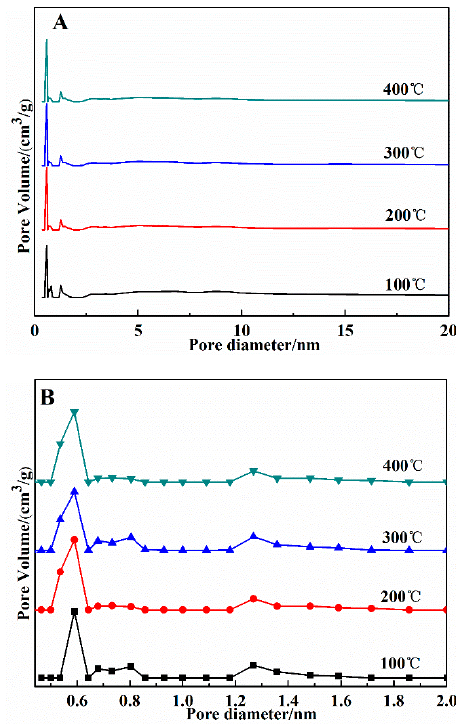
Figure 1. N 2 adsorption–desorption isotherms for 10 wt% NiP/H β calcined at different temperatures.